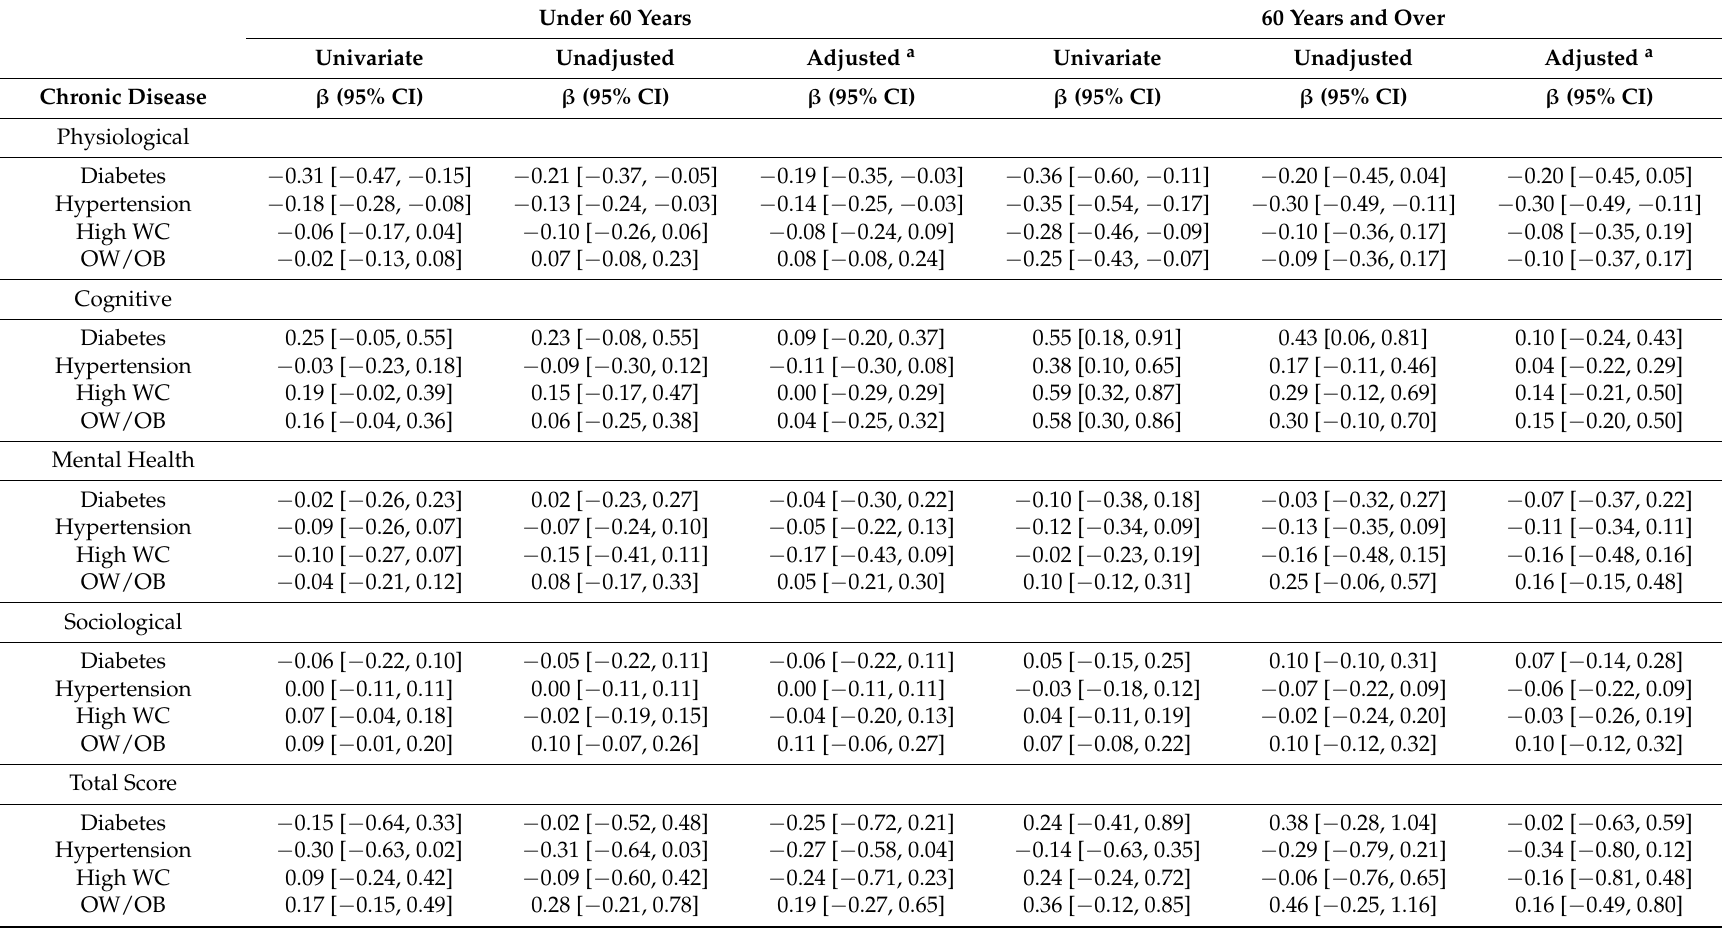
Table 3. Age-stratified associations between chronic diseases and successful aging domain and total scores. Under 60 Years 60 Years and Over Univariate Unadjusted Adjusted a Univariate Unadjusted Adjusted